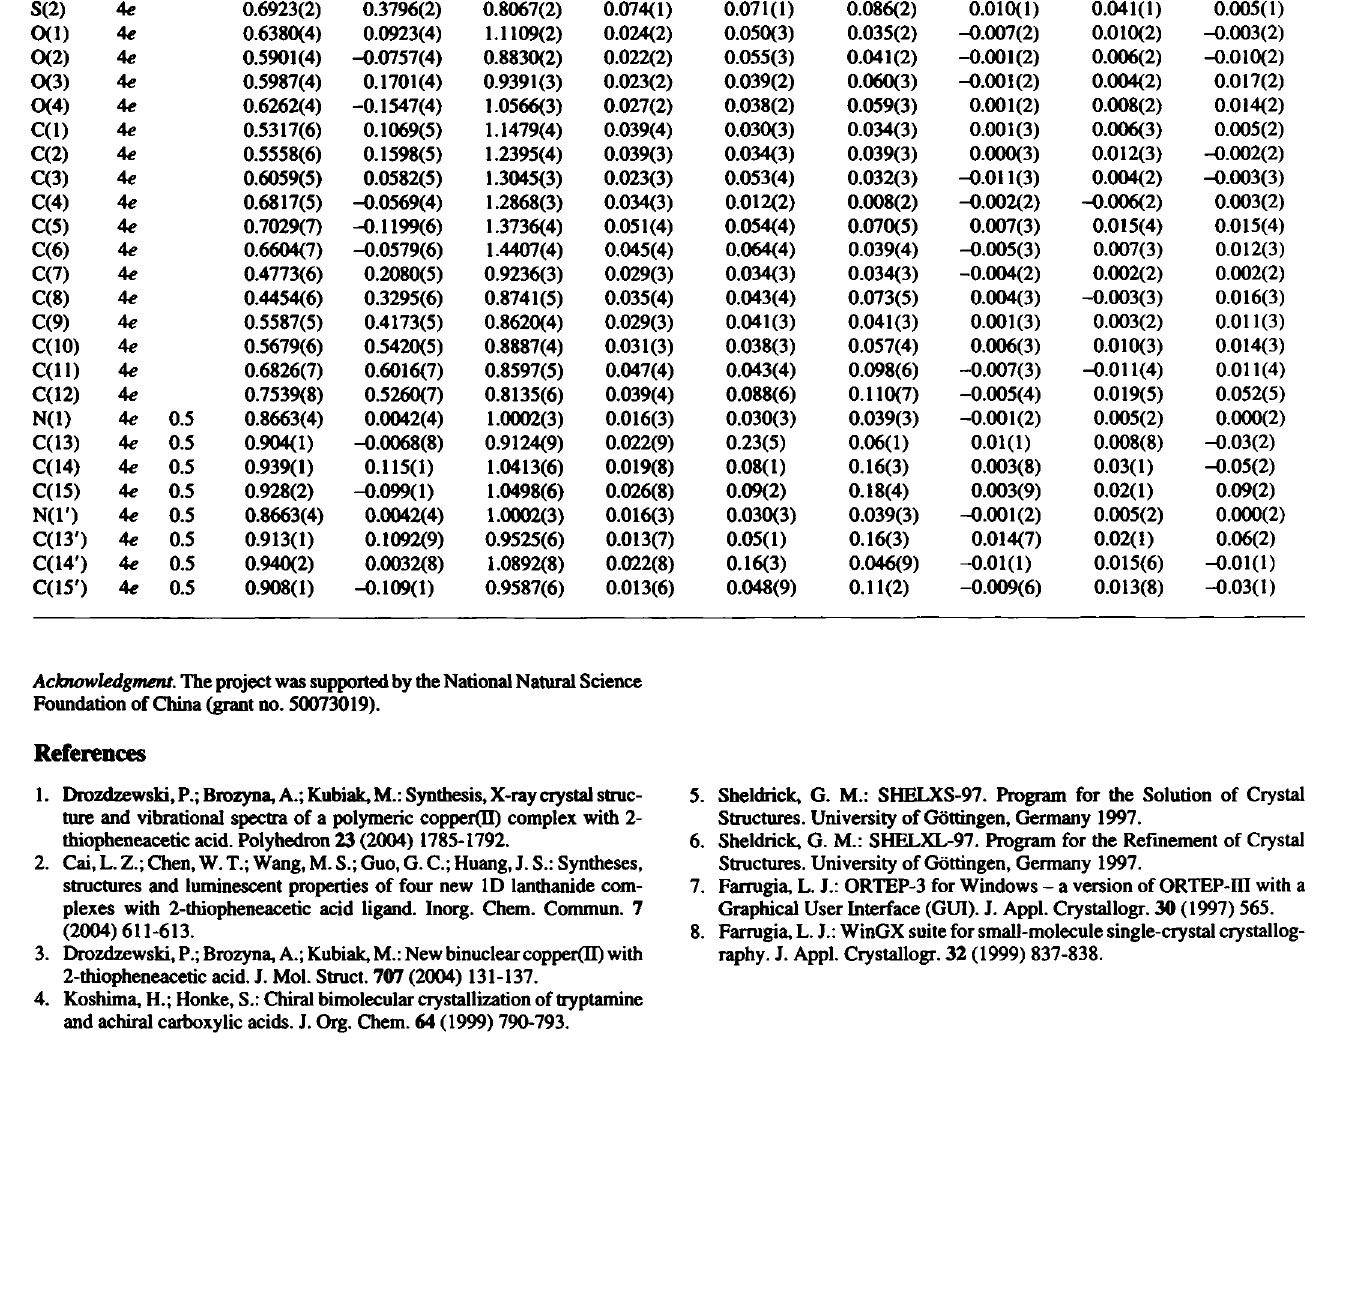
Table 3. Atomic coordinates and displacement parameters (in Ä 2